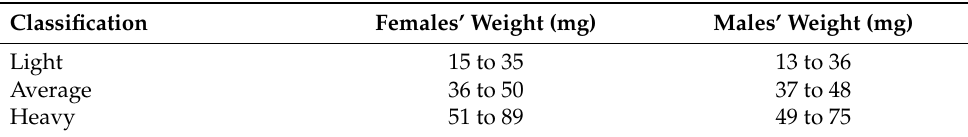
Table 1. Classification of Anastrepha curvicauda females and males according to their weight. Classification Females’ Weight (mg) Males’ Weight (mg) Light 15 to 35 13 to 36 Average 36 to 50 37 to 48 Heavy 51 to 89 49 to